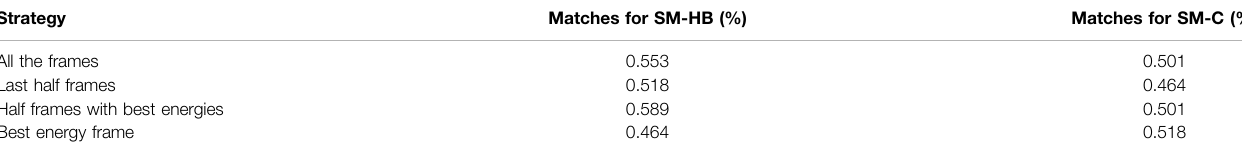
TABLE 3 | Prediction ofthe sign ofthe experimental activity differences by single-point mutations ofthe peptide core amino acids using the scoring-matrix calculated based on the hydrogen bonds made by main chain atoms (SM-HB) and the number of non-bonded contacts (SM-C). The comparisons include data for the four strategies to extract information from the 2,000 backrub